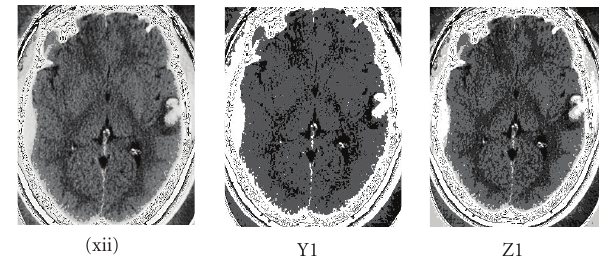
Figure 7: k-means